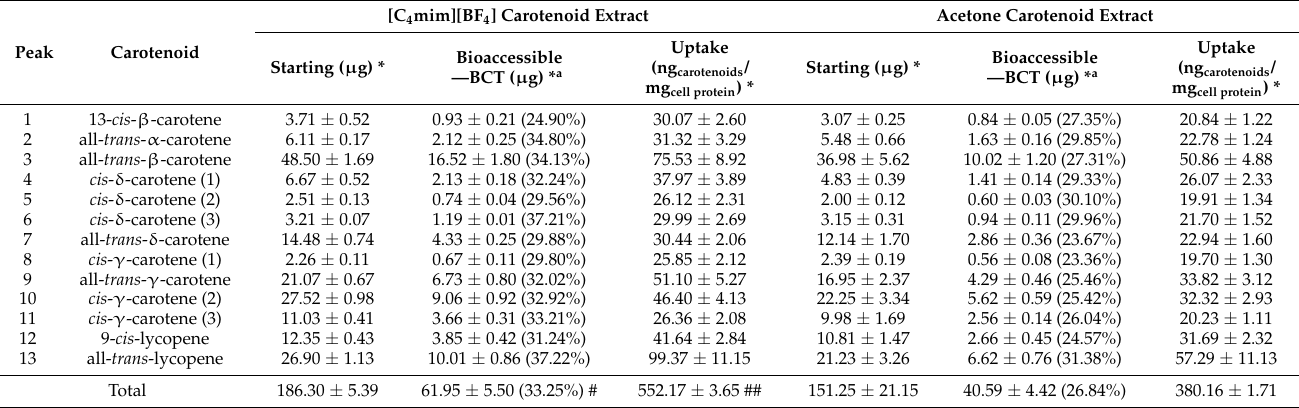
Table 3. Initial carotenoid content in the initial stage (emulsion samples), micelles fractions after in vitro digestion (BCT), and carotenoids absorbed (uptake).